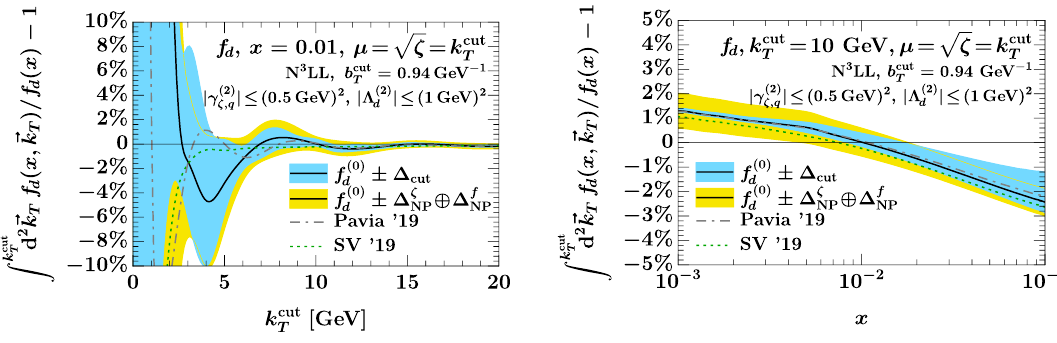
Figure 6 . The normalized deviation of the transverse-momentum integral (with an upper limit) of the TMD PDF from the collinear PDF as a function of the transverse-momentum cutoff k cut T (left) and of the momentum fraction x (right). The blue band shows the uncertainty from varying the position-space integral cutoff b cut , and the yellow band shows the uncertainty from varying the T quadratic OPE coefficients γ (2) and Λ (2) q . We also include the cumulative TMD PDF as predicted by ζ,q SV and Pavia global fits, both of which show small deviation from the collinear PDF. We approximate the transverse-momentum integral of the TMD PDF with K (3) [ f (0) ] , which is purely perturbative. i √ In both figures, the evolution scales are set to be µ = ζ = k cut , and the TMD PDF is for a down T quark. See figure 12 in appendix B for the results for other light quark flavors including u, ¯ d, ¯ u , and s